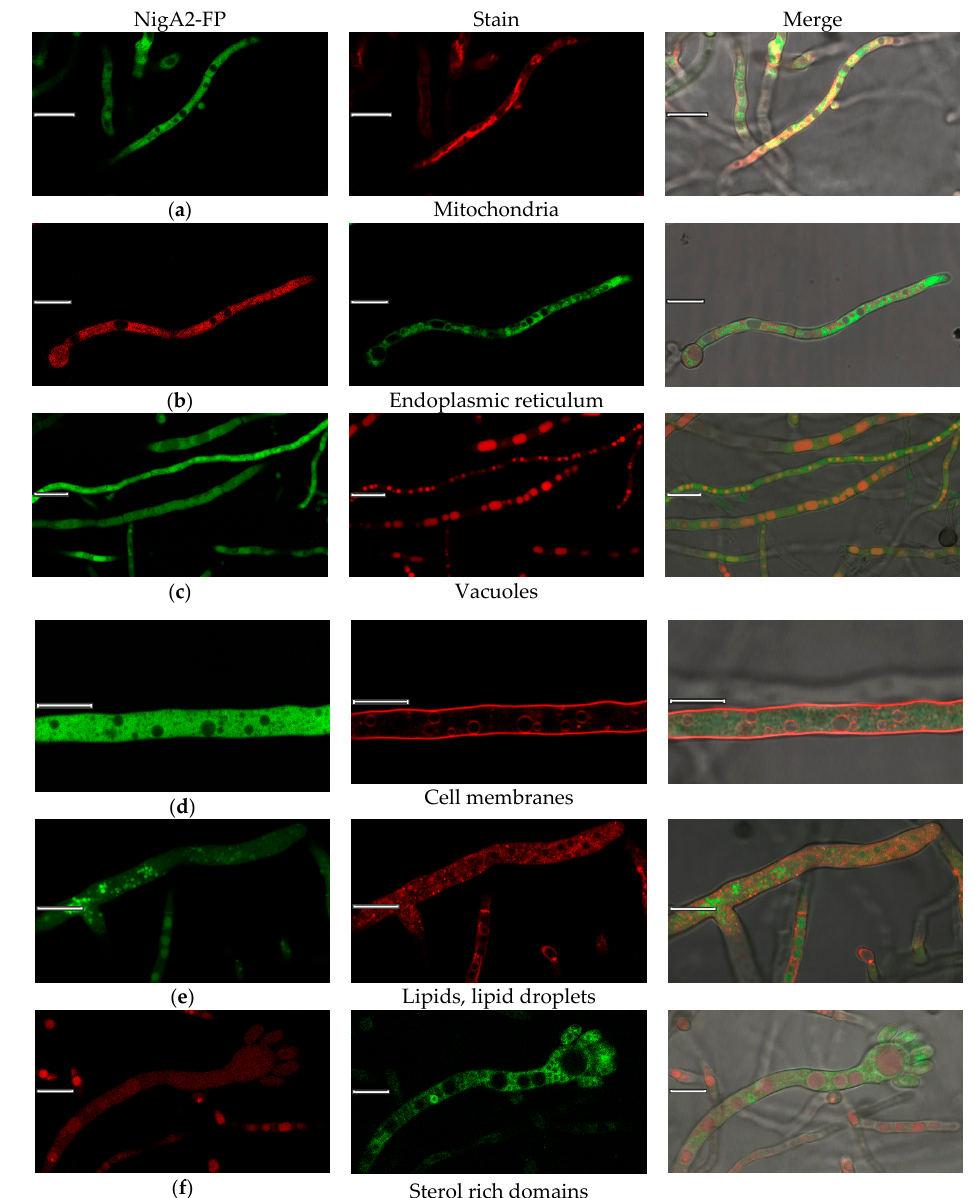
Figure 5. Colocalization of NigA2-fluorescent fusion protein and vital dyes in the fungus Aspergillus niger . NigA2-eYFP (in green) or NigA2-mCherry fusion-proteins (in red) are merged with dyes: ( a ) Mito Tracker® Deep Red; ( b ) ER-Tracker™ Blue-White DPX; ( c ) Cell Tracker™ CMAC Blue; ( d ) Synapto Red™; ( e ) Nile Red; and ( f ) Filipin. Size of a ruler line was 10 μ m.